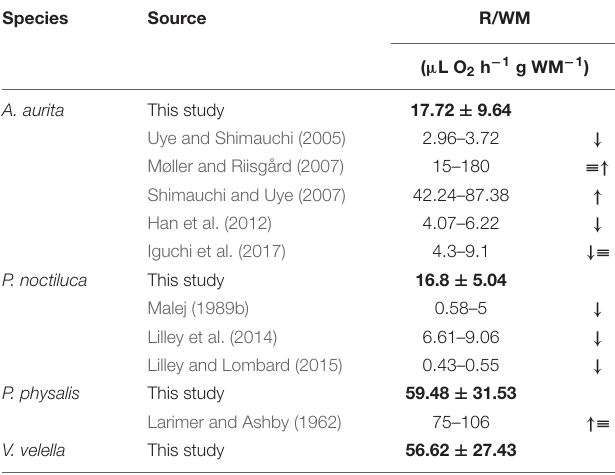
TABLE 1 | Wet mass (WM) specific physiological respiration (R) results for each of the species studied here in the format of mean ± SD.